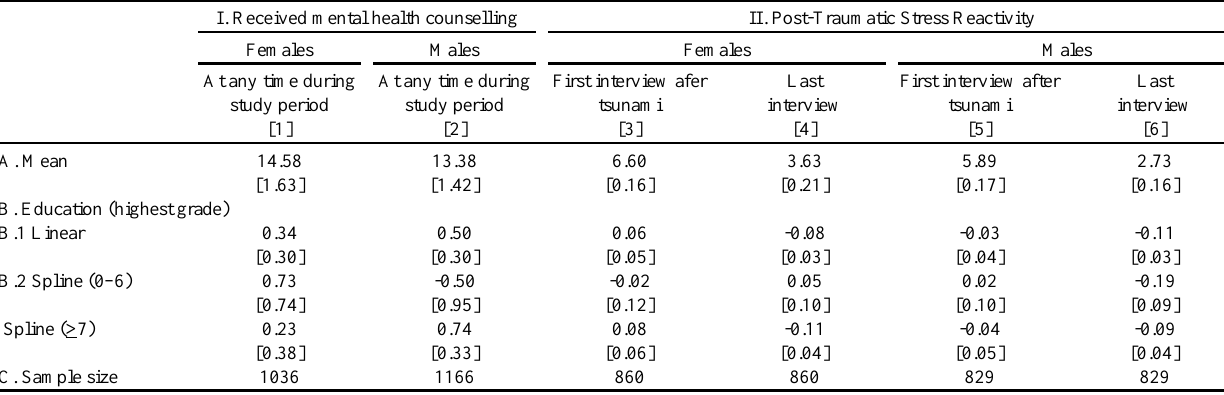
Table 4. Mental health counseling and post-traumatic stress